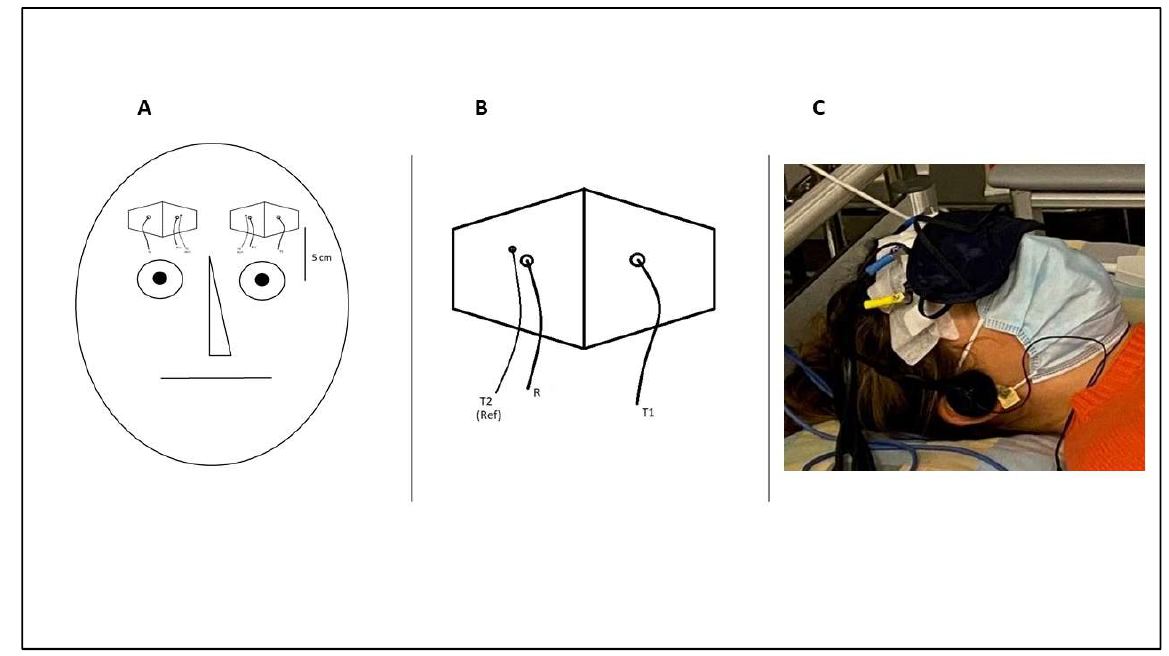
Figure 2. ( A ) The optodes were placed on the forehead approximately 5 cm above the mediopupil- lary line. ( B ) Optode configuration. R = receiver. T1 = main infrared light transmitter. T2 (reference) = secondary infrared light transmitter (“short channel”). ( C ) Subject 6 during experiment; the optodes were fixed with patches on the forehead.